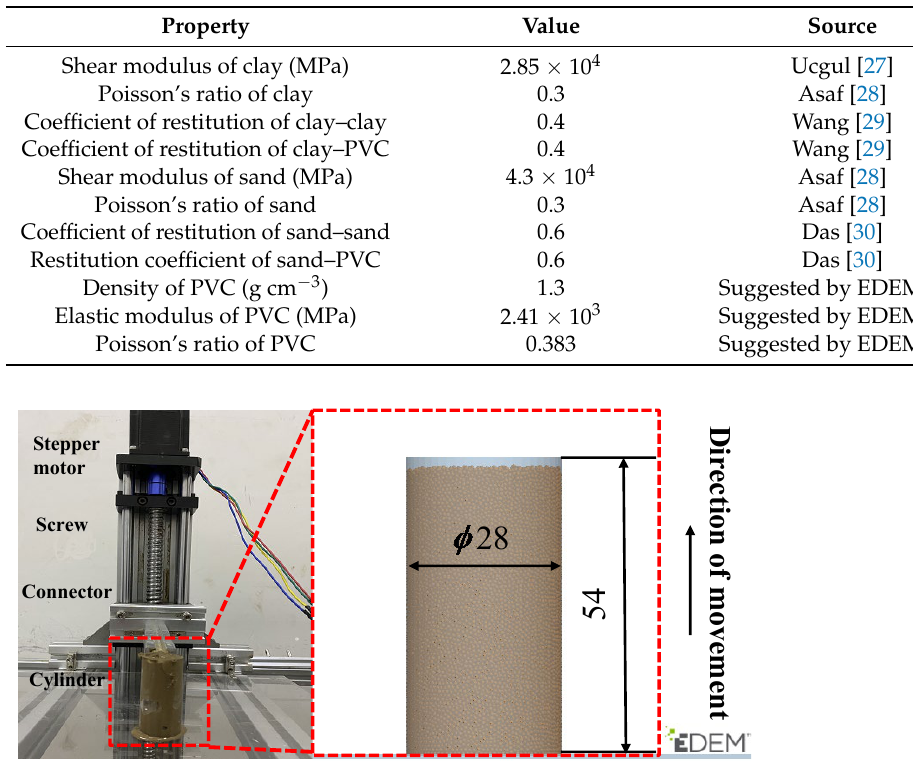
Figure 2. Bottomless cylinder in accumulation test and